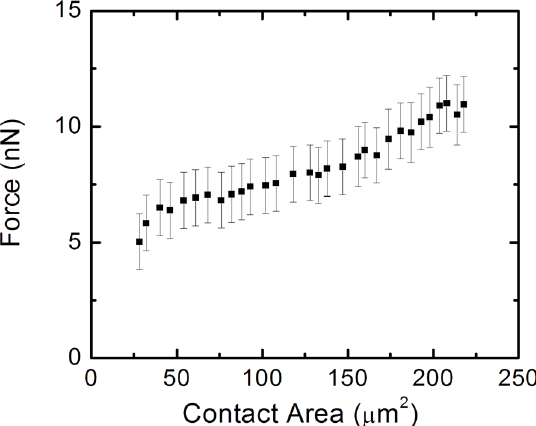
Figure 9. Plot of total traction force against the contact area of the cell for several neurons with growing axons. Error bars represent the standard error of the mean. The traction force increases with increasing contact area, as predicted by the contact guidance model.